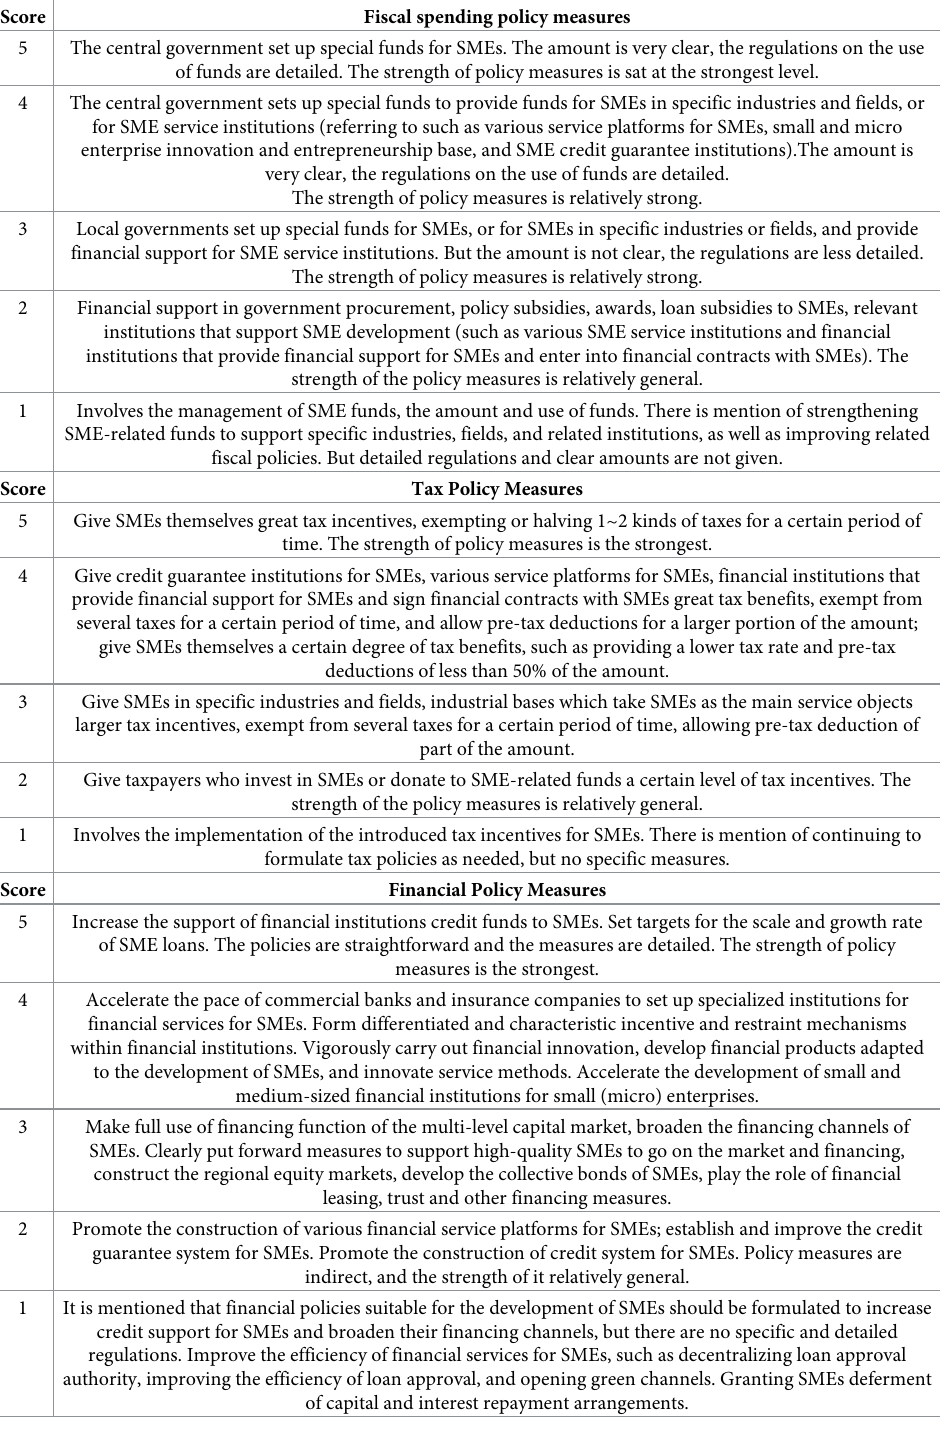
Table 2. Criteria for assigning value to policy measures. (See S3 Appendix for further